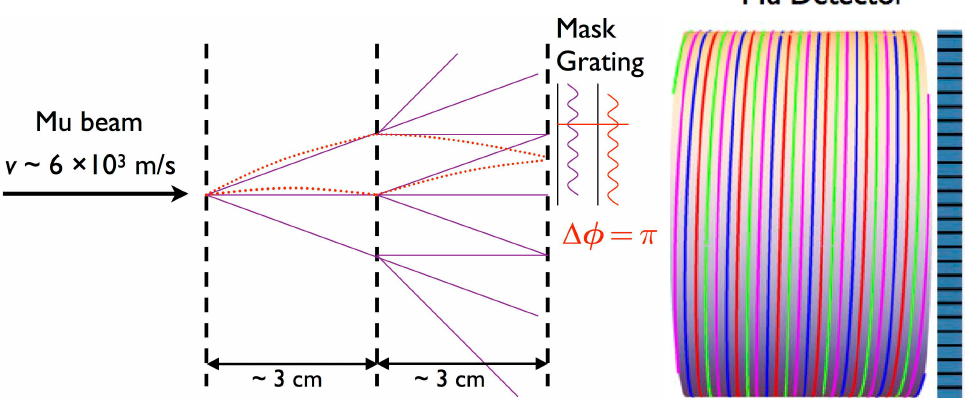
Figure 1. Principle of three-grating muonium-gravity interferometer, shown schematically in elevation view, with gravitational deflection and phase shift ∆ φ exaggerated for clarity. Muonium beam enters from left, slow-electron detector is at right. Not shown: ring electrodes, which accelerate slow electrons onto their detector, starting downstream of grating 3 and continuing within (helically wound) scintillating-fiber-barrel positron-tracking detector; and scintillating-bar hodoscope surrounding positron-tracking